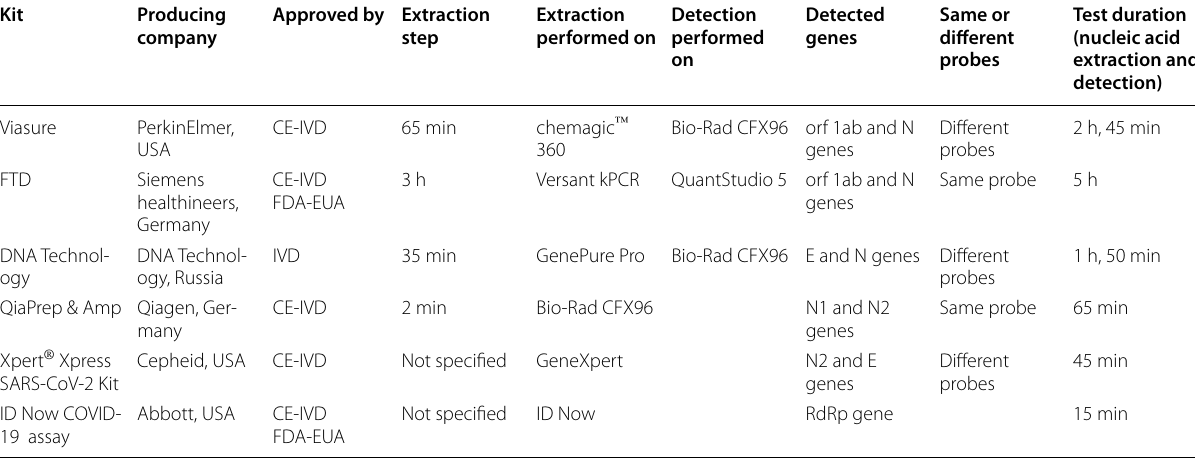
Table 1 Summary of the tested RT-PCR systems in this